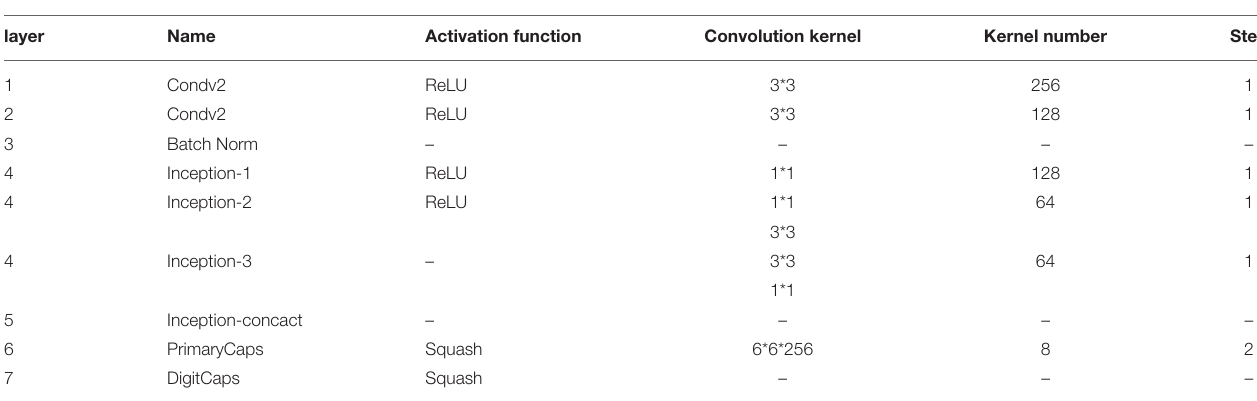
TABLE 2 | CNN network structure on the